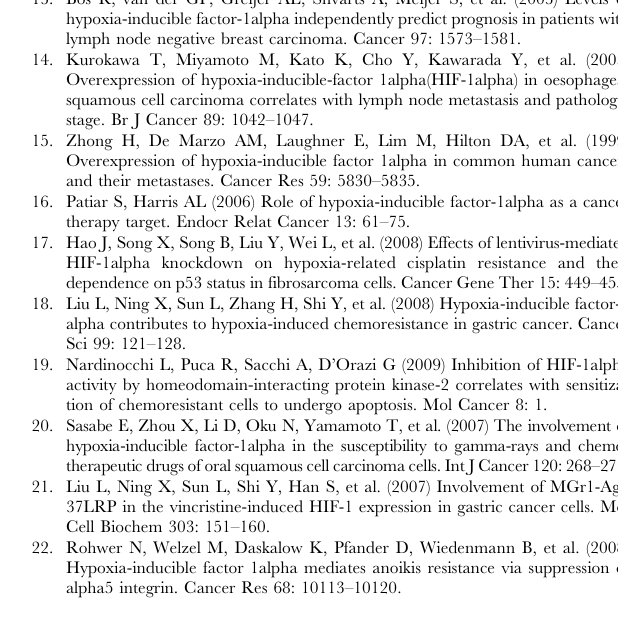
Figure S4 Overexpression of NF- k B subunit p65 in AGS KD cells. AGS KD cells were co-transfected with either pcDNA p65 or pcDNA 3.1 plus Ig k B-Luc and phRL-null as internal control. Cells were harvested 48 h post transfection and NF- k B luciferase activity, normalised for Renilla luciferase activity, was expressed relative to control transfected cells (***, P , 0.001). Bottom panel shows immunoblot analysis of p65 and actin 48 h post transfection. Figure S5 Analysis of superoxide anion levels in AGS cells after 5-FU treatment. AGS KD and SCR cells were treated for 24 h with 10 m g/ml 5-FU under normoxia, stained with 10 m mol/L dihydroethidium, and dye oxidation was determined by flow cytometry. Values represent the mean 6 SEM of three independent experiments (**, P , 0.01). Table S1 List of primer and probe sequences.